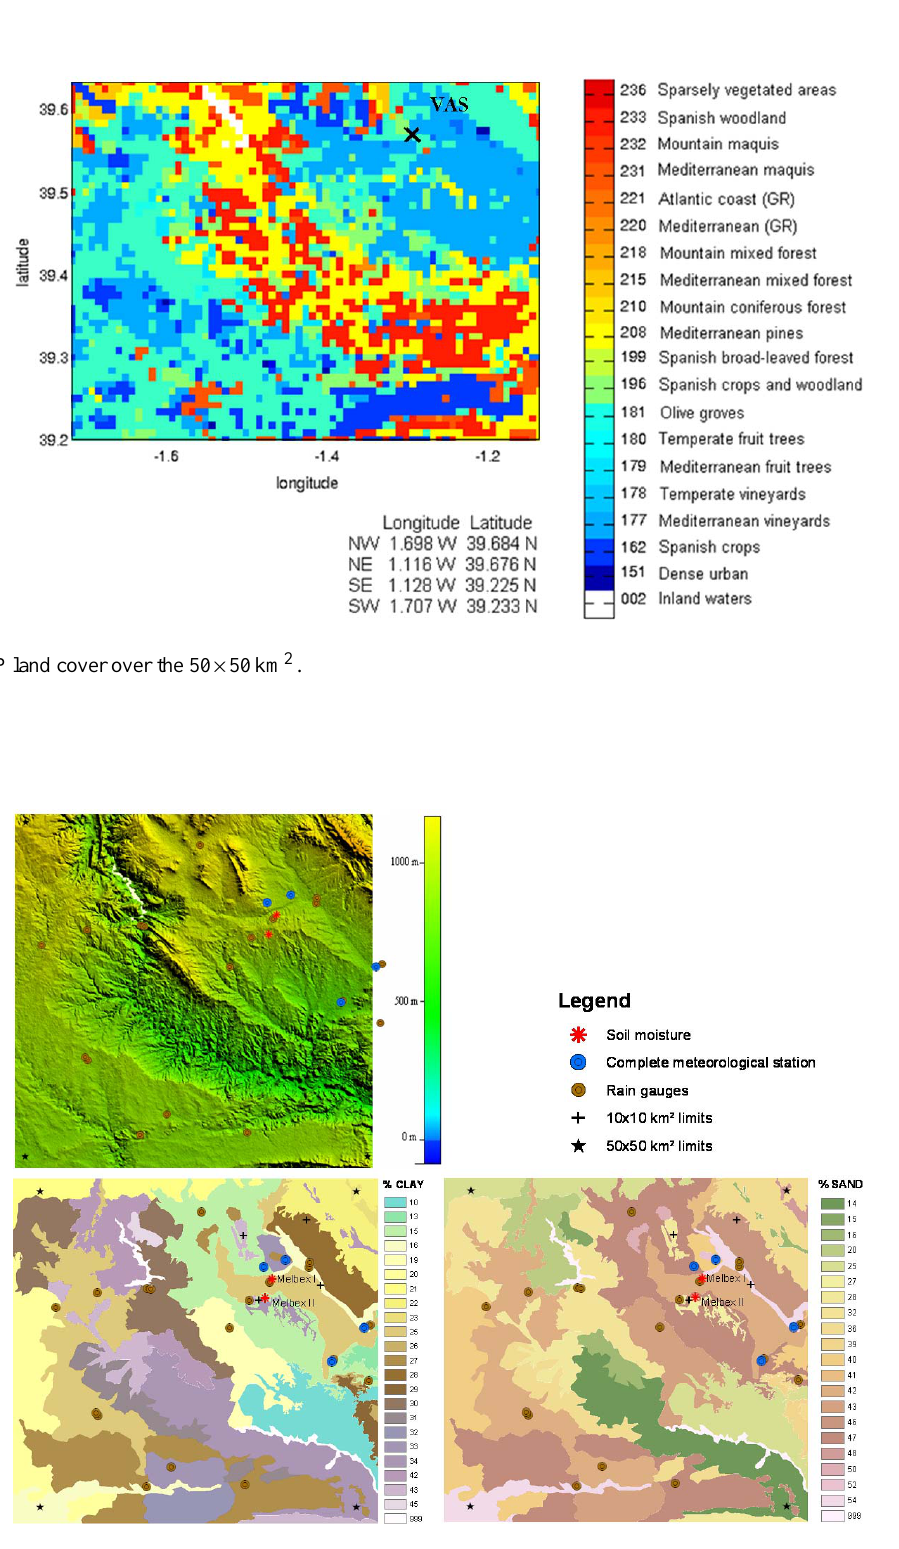
Fig. 3. Topography (up left side), clay (down left side) and sand (down right side) maps over the VAS 50 × 50km 2 area. The soil moisture measurements sites and meteorological station/rain gauges are also represented